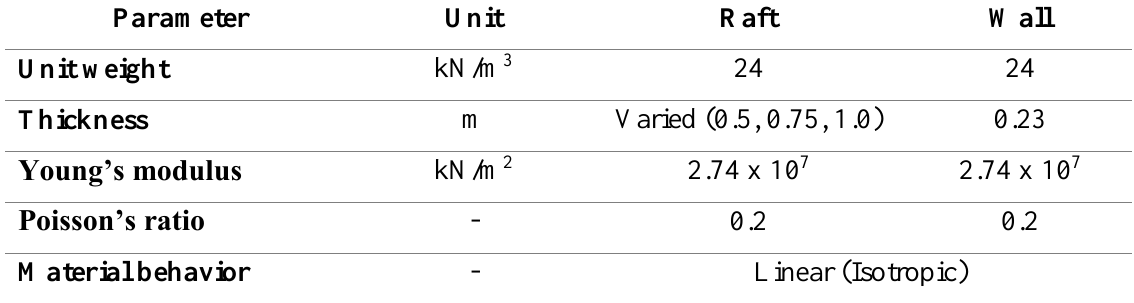
Material properties for raft and wall above raft footing in numerical